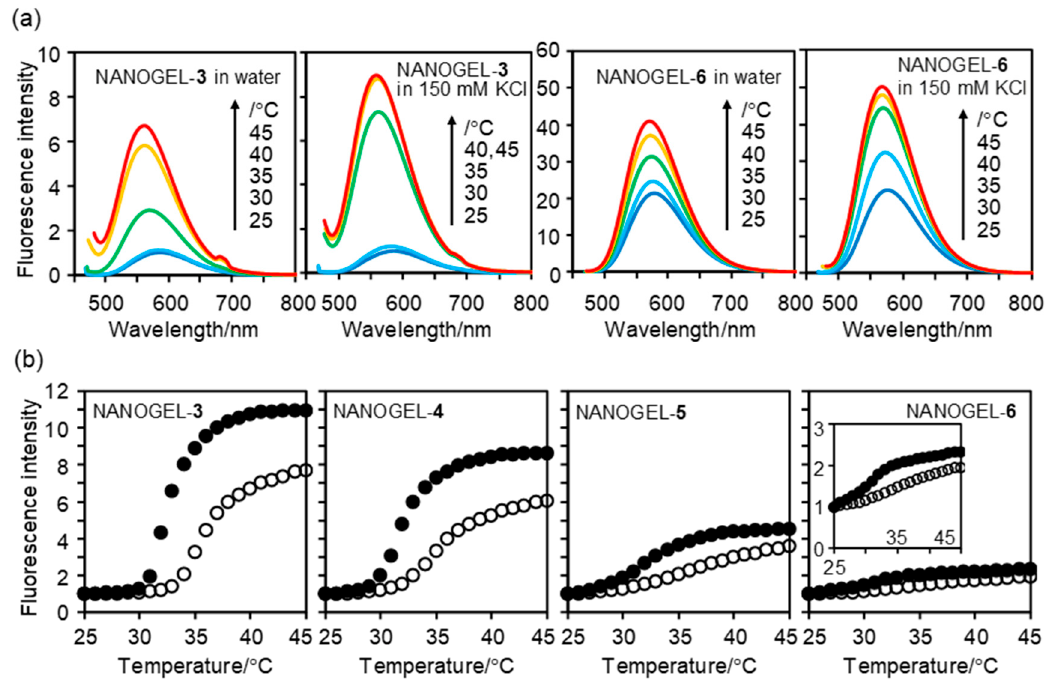
Figure 3. Fluorescence response of NANOGEL- 3 ~ 6 to temperature variation. ( a ) Temperature- dependent fluorescence spectra of NANOGEL- 3 and NANOGEL- 6 in water and 150 mM KCl aqueous solution. The vertical units in (a) are identical.; ( b ) Fluorescence intensity of NANOGEL- 3 ~ 6 in water (open circle) and 150 mM KCl aqueous solution (closed circle) at λ em at 45 °C (see Table 2). The inset for NANOGEL- 6 is vertically expanded. Concentration of NANOGEL- 3 ~ 6 : 0.01 w/v%; excitation: 456 nm. The shoulders at approximately 684 nm in the fluorescence spectra at 40 and 45 °C in panel (a) were due to the scattered excitation light.